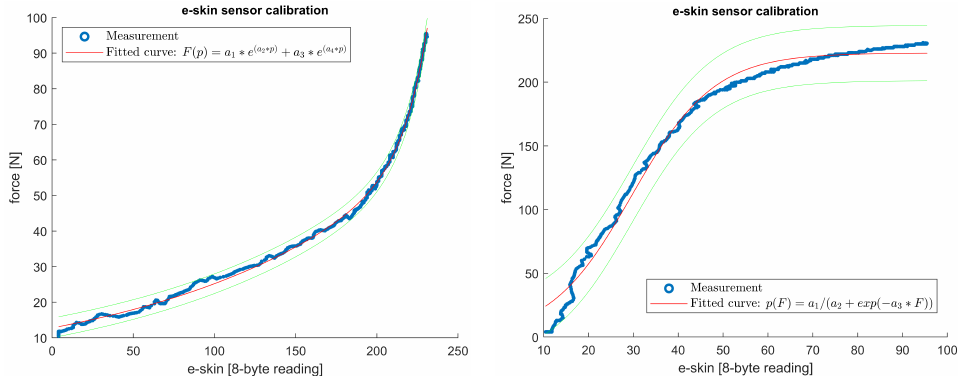
Figure 11. Example plot of curve fitting for measurements in the loading phase of the e-skin sensor from row 15, column 29. On the left is the fit according to formula (1) and on the right according to formula (2). Green lines indicate the 95% confidence